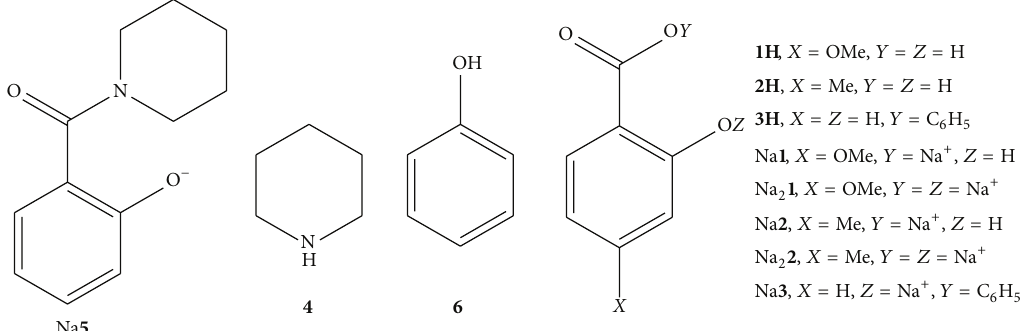
Figure 1: Molecular structures of compounds 1H , Na 1 , Na 2 1 , 2H , Na 2 , Na 2 2 , 3H , Na 3 , 4 , Na 5 , and 6 .